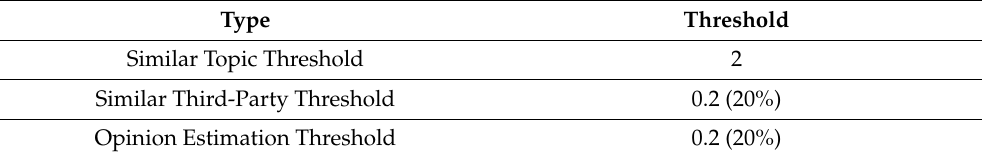
Table 7. Opinion dialogue system